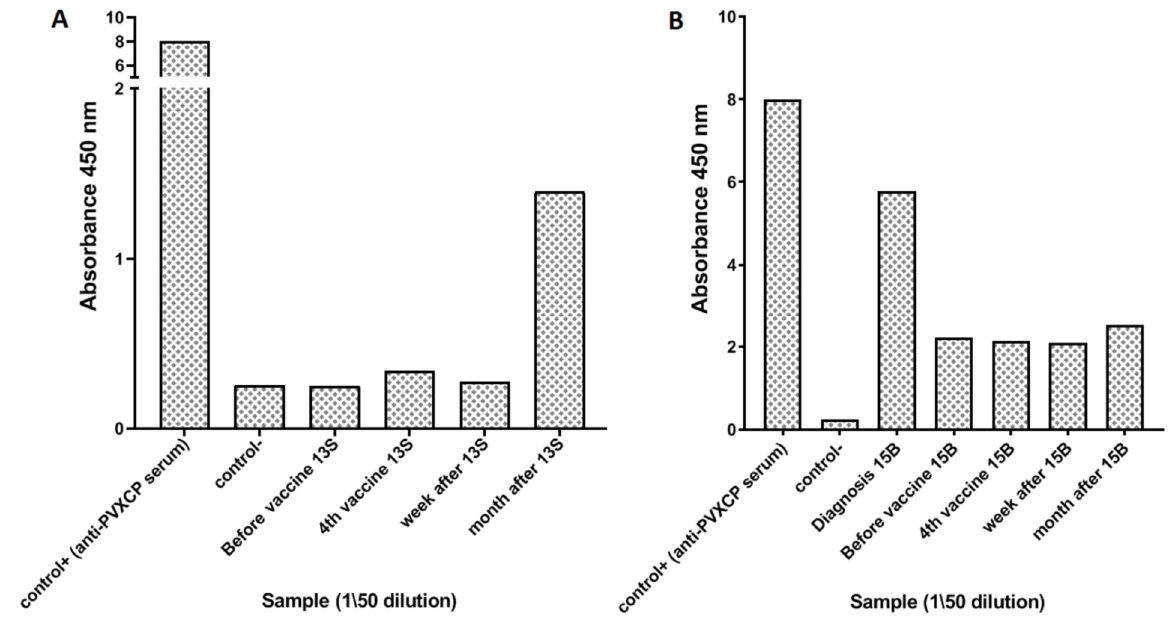
Figure 4. Anti-Id antibody responses for patients 13S ( A ) and 15B ( B ).